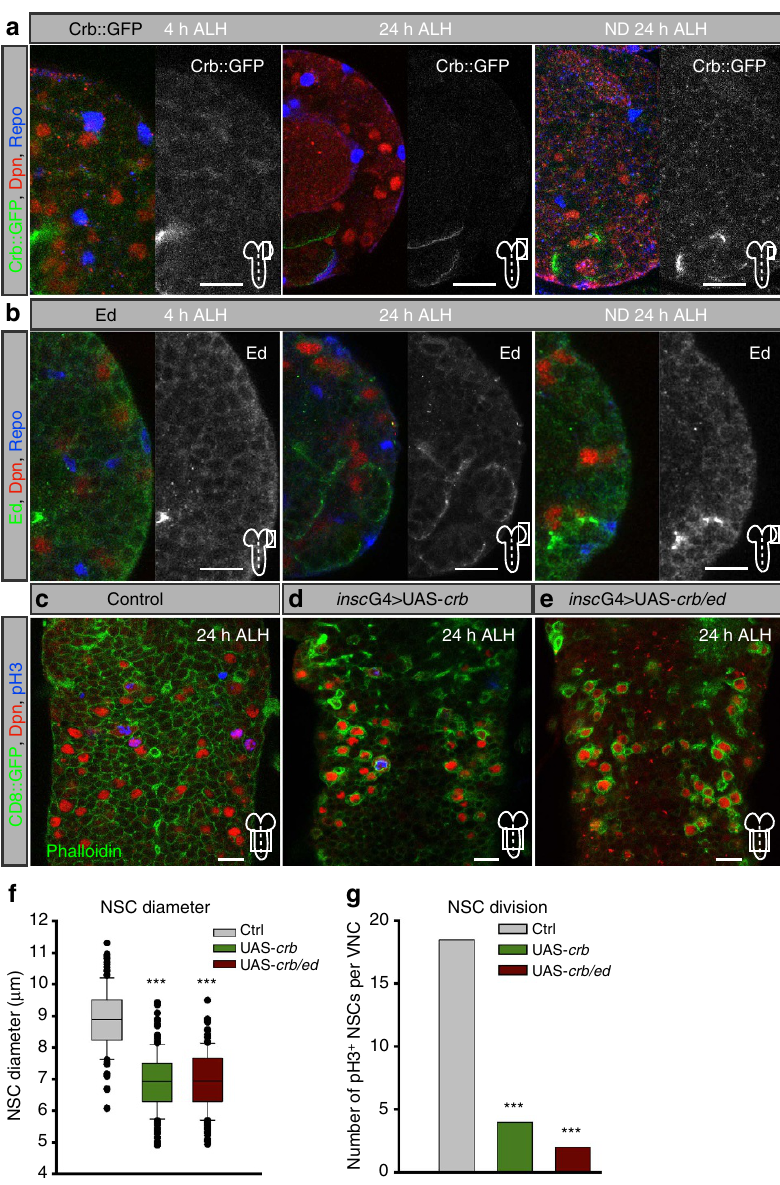
Figure 6 | Crumbs and Echinoid are temporally expressed in glial cells and NSCs during quiescence and prolonged expression suppresses NSCs growth and proliferation. ( a ) Expression of Crumbs::GFP at 4, 24 and 24h in nutrition-deprived (ND) ALH. Right side of each panel shows the GFP channel in monochrome. Crumbs expression is lost in both glial and NSCs after reactivation but persists in ND. ( b ) Expression of Echinoid at 4, 24 and 24h in nutrition-deprived (ND) ALH. Right side of each panel shows the Echinoid channel in monochrome. Echinoid expression is lost in glial cells at 24h ALH, while NSCs still express Echinoid, but persists in ND. ( c - e ) In comparison with wild type ( c ) prolonged expression in NSCs of crb ( d ) or crb/ed ( e ) leads to suppression of NSCs cell growth and division in ventral nerve cord NSCs at 24h ALH. ( f , g ) Quantification of NSC cell diameters and mitosis upon NSC- specific prolonged expression of crb or crb / ed at 24h ALH. ( f ) *** P o 0.001. Wilcoxon rank sum test. Median and s.d. were calculated from two biological replicates. Control VNCs n ¼ 129 NSCs (3 VNCs); insc G4 4 UAS- crb, n ¼ 144 NSCs (3 VNCs); insc G4 4 UAS- crb/ed, n ¼ 165 NSCs (3 VNCs). ( g ) Ratio of NSCs in mitosis (pH3-positive) per counted VNCs at 24h ALH in wild type of 3 VNC and insc G4 4 UAS- crb of 3 VNCs and insc G4 4 UAS- crb / ed of 3 VNCs. All images are single focal planes, anterior up. Scale bar, 10 m m. See also Supplementary Fig.